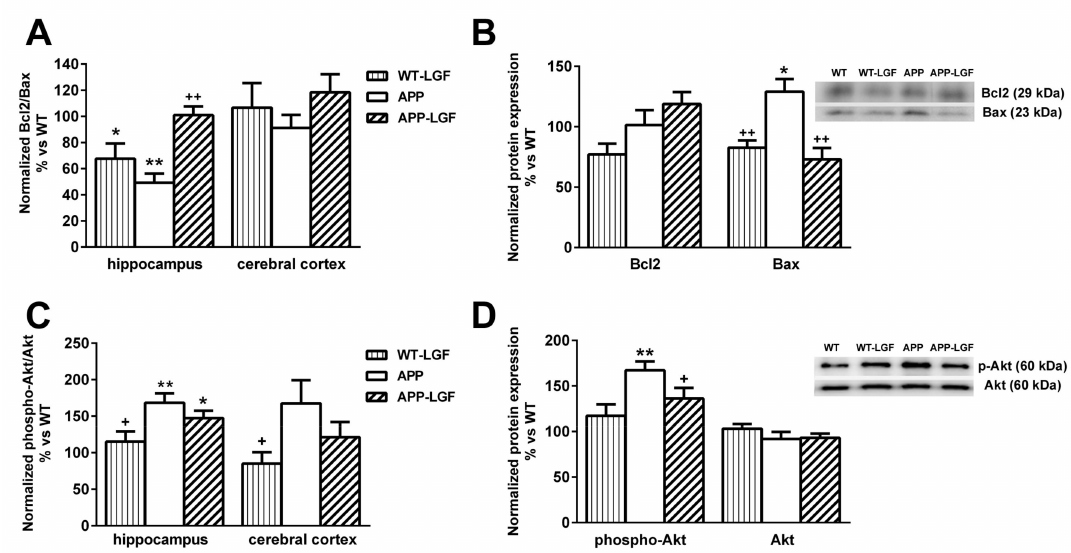
Figure 6. E ff ect of LGF on the expression of proteins involved in cell survival. Protein expression was analyzed by Western blot using specific antibodies against Bcl2, Bax, p-Akt and Akt. Panel ( A ), shows that LGF increases Bcl-2 / Bax ratio in the hippocampus. This e ff ect is mainly due to a reduction in Bax protein levels ( B ). Panels ( C , D ) show that phospho-Akt / Akt ratio ( C ) and phospho-Akt protein levels ( D ) are significantly increased in the hippocampus of APP and APP-LGF treated mice. Results represent the mean ± SEM of 4 to 8 independent mice. The statistical analysis was performed by one-way ANOVA followed by Newman–Keuls test. * p ≤ 0.05, ** p ≤ 0.01, vs. WT. + p ≤ 0.05, ++ p ≤ 0.01 vs. APPswe